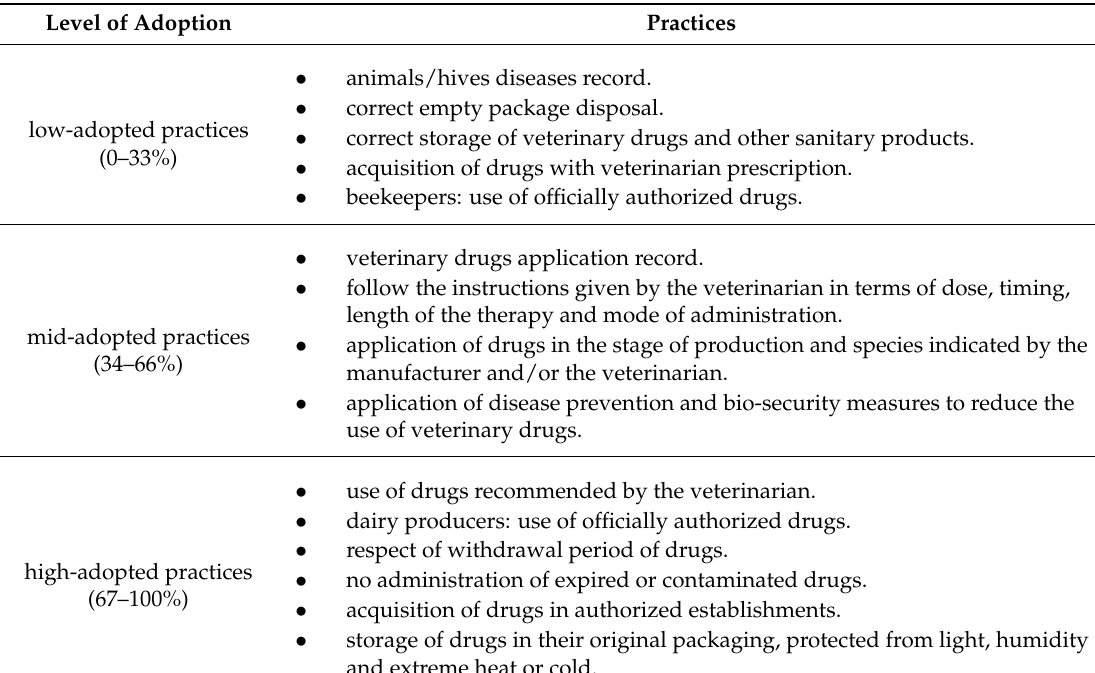
Table 2. Good practices adoption rate (GPAR): Level of adoption of good practices in veterinary drug use for dairy producers and beekeepers.